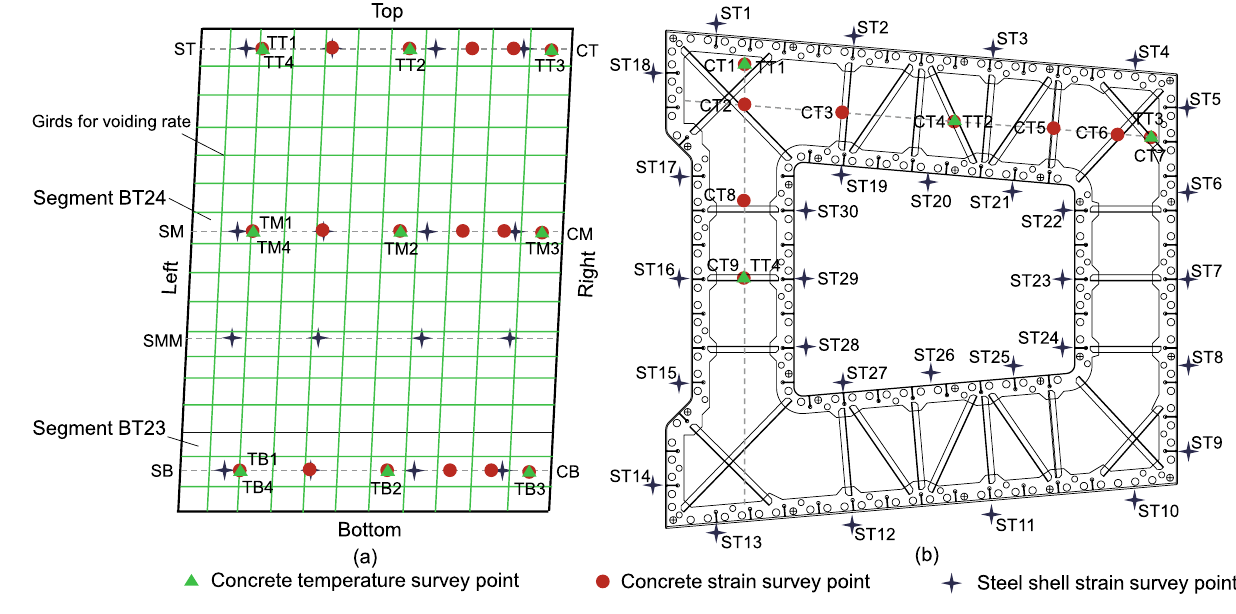
Figure 10. Survey points layout of the full scale model: ( a ) distribution of survey points in elevation map; ( b ) distribution of survey points in pylon section.